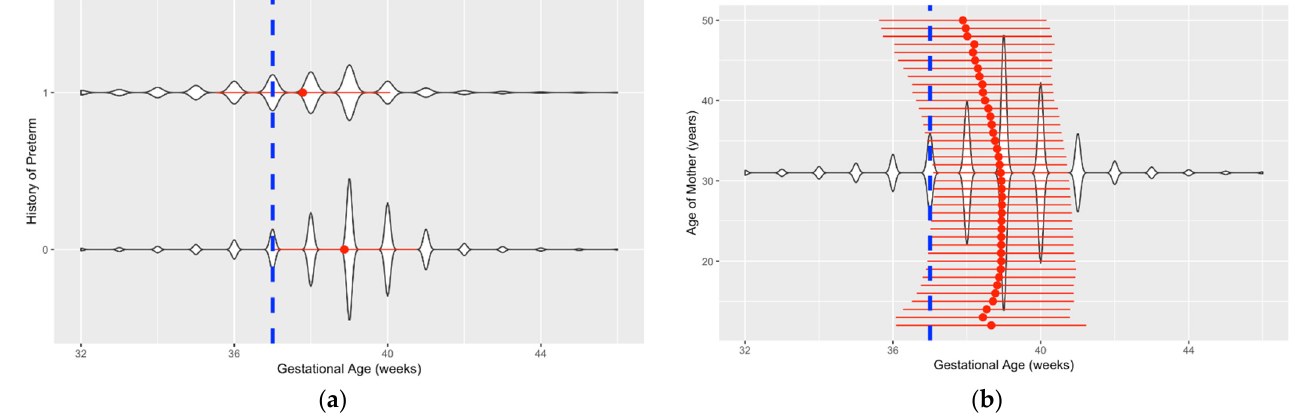
Figure 3. Data visualization for the kernel distribution of variables versus gestational age. ( a ) Gestational age vs. history of preterm birth; ( b ) gestational age distribution vs. age of the mother.